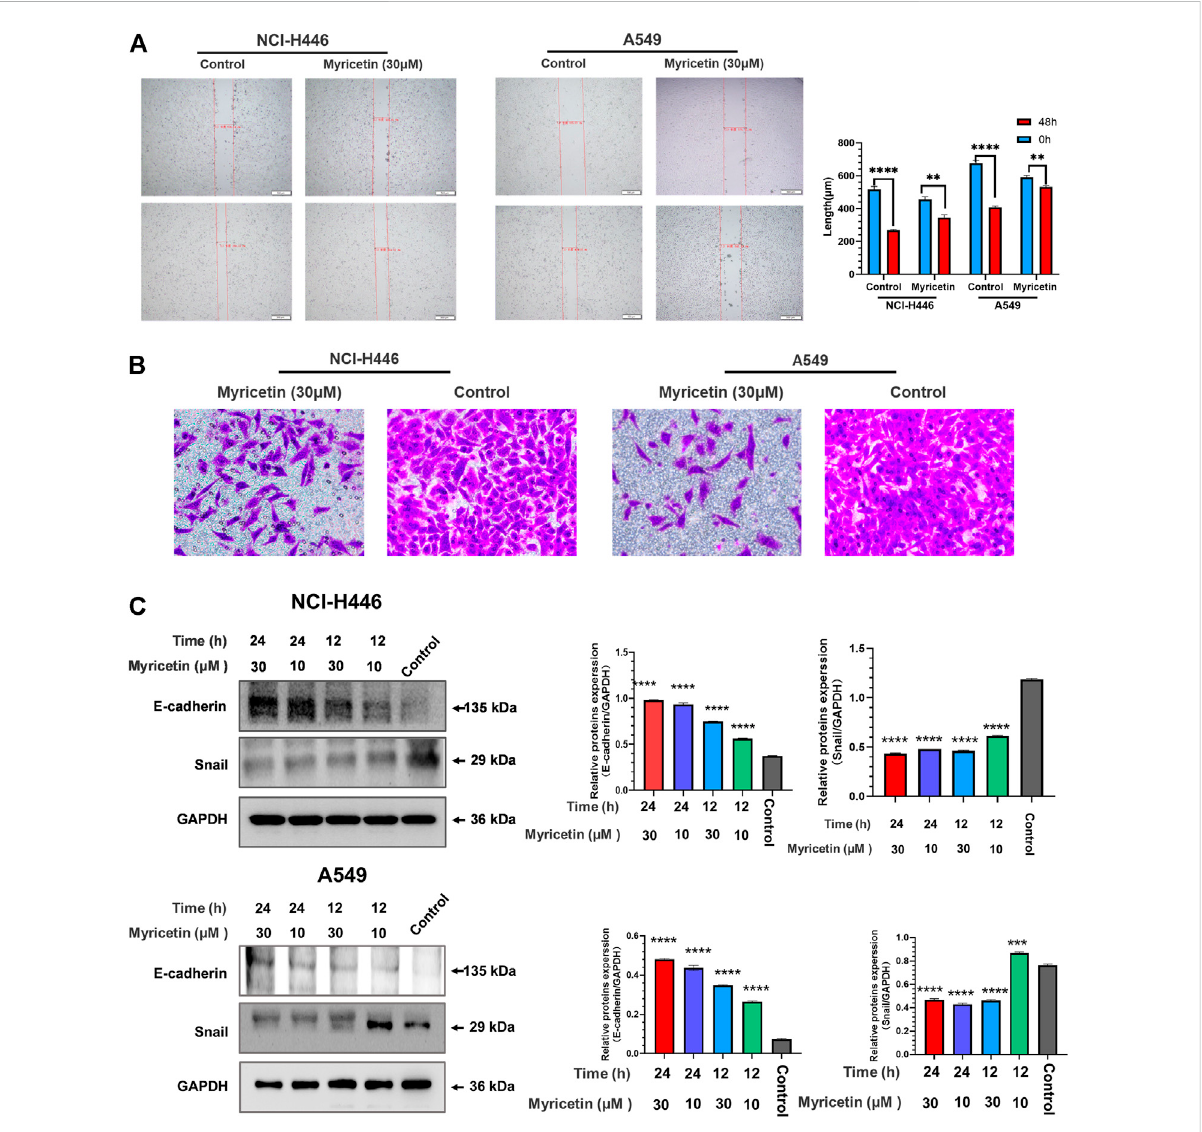
Analysis of myricetin inhibition of lung cancer cells ’ migration and invasion. Wound scratch assay of NCI-H446 and A549 cells treated with myricetin (30 μ M) and its statistical analysis (A) . (B) Migration analysis of myricetin (30 μ M) -treated NCI-H446 and A549 cells. Western blot analyses ofE-cadherinand Snail expression inNCI-H446 and A549 cells after myricetin (10and30 μ M) treatment and their correspondingstatisticalanalyses (C) . The results were presented as mean ± standard deviation (**** p < 0.0001, when compared with